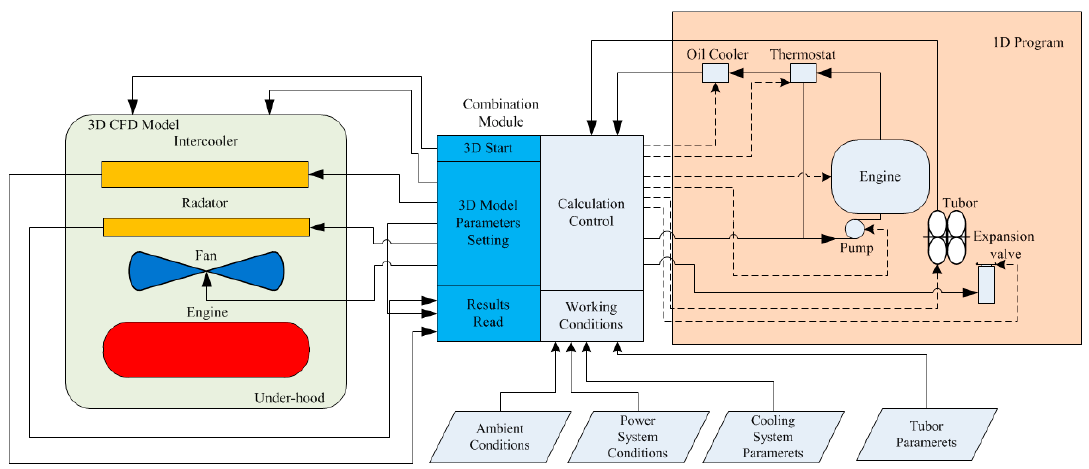
Figure 10. The schematic diagram of the combination of 1D and 3D scheme of ITM for ICE.